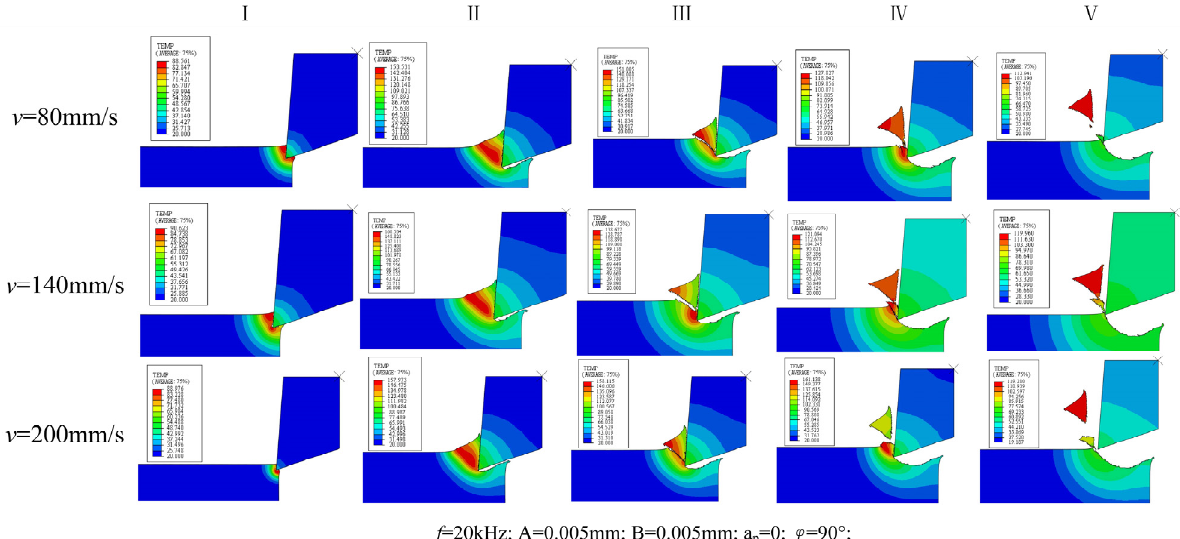
Figure 12. Material removal process at different cutting speeds.